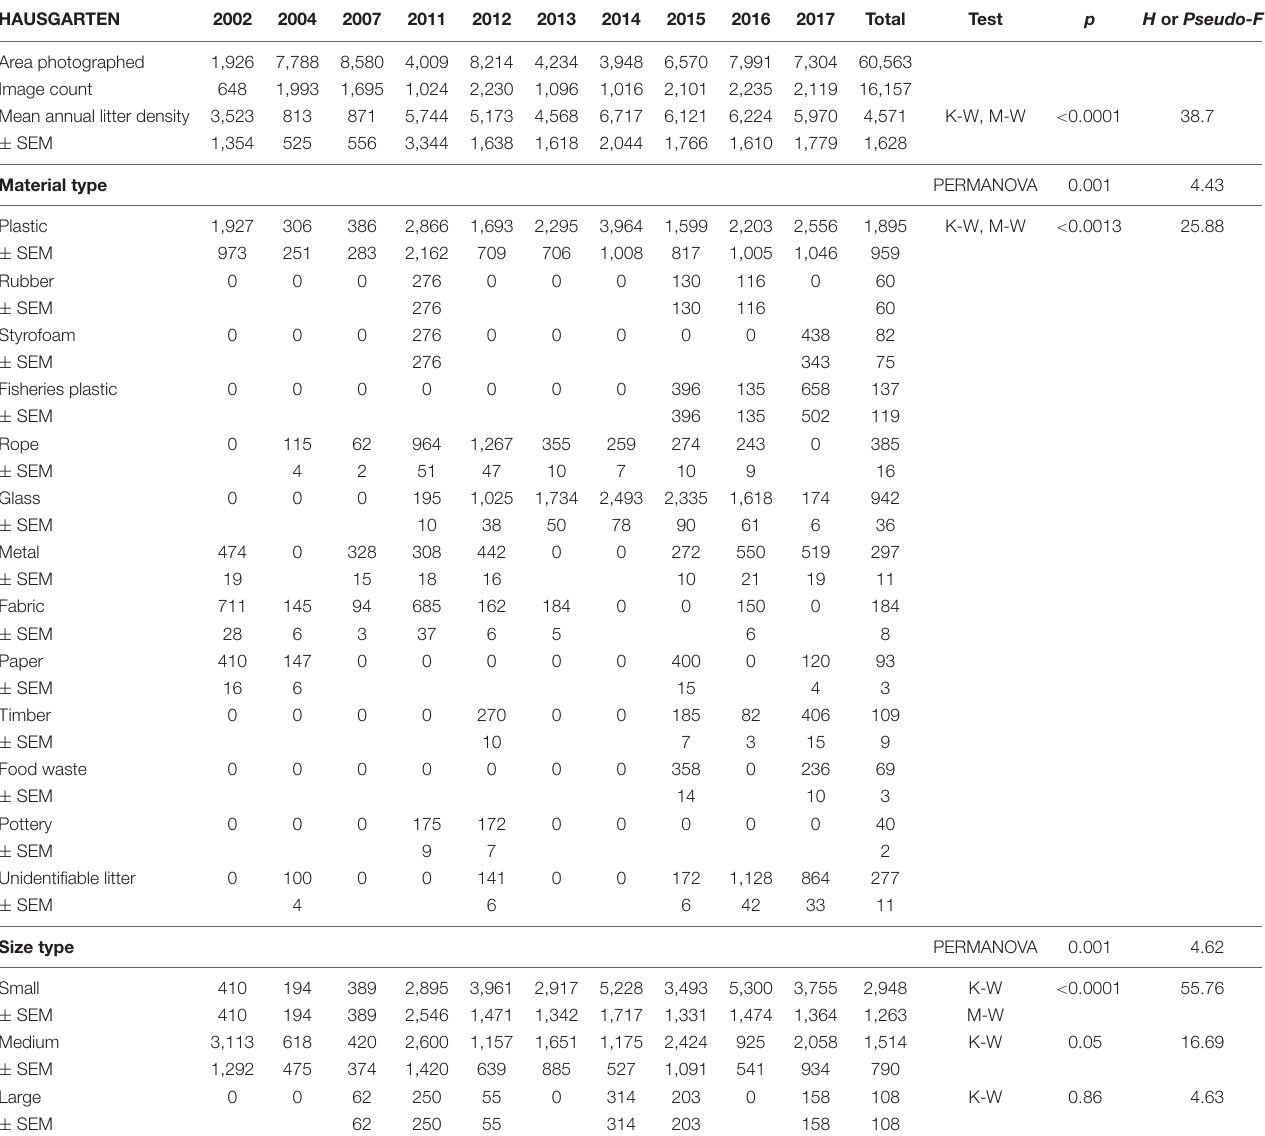
TABLE 2 | Summary of the area covered (m 2 ), mean annual litter densities (items km − 2 ), material and size composition at all HAUSGARTEN stations combined.